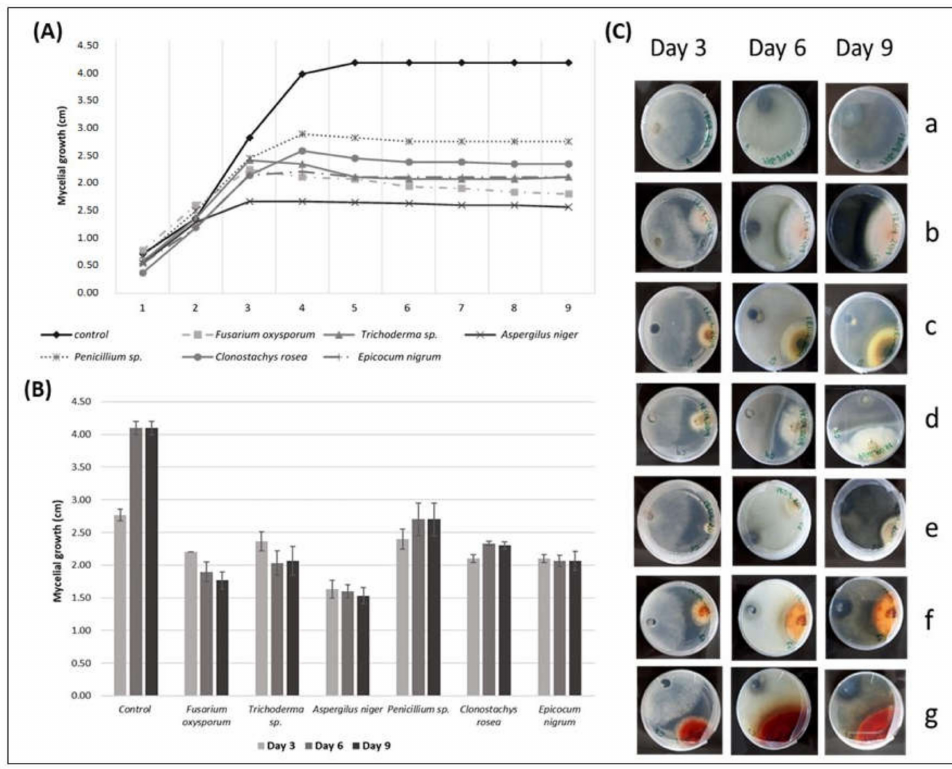
Figure 3. ( A ) The radial mycelial growth (cm) of Phialophora fastigiata over time (days), registered in direct inhibition tests with some endophytic fungi; ( B ) radial growth values of P. fastigiata (cm) (r P. fastigiata ± SE) in the presence of di ff erent endophytic fungi on the 3rd, 6th, and 9th day of direct antagonism test; ( C ) interactions of P. fastigiata , over the days, with grapevine endophytic fungi. P. fastigiata on the left side and the endophytic on the right side of the Petri dish. ( a ) P. fastigiata (control), ( b ) P. fastigiata vs. Fusarium oxysporum , ( c ) P. fastigiata vs. Trichoderma sp., ( d ) P. fastigiata vs. Aspergillus niger , ( e ) P. fastigiata vs. Penicillium sp., ( f ) P. fastigiata vs. Clonostachys rosea , ( g ) P. fastigiata vs. Epicocum nigrum. Pictures from the reverse side of the